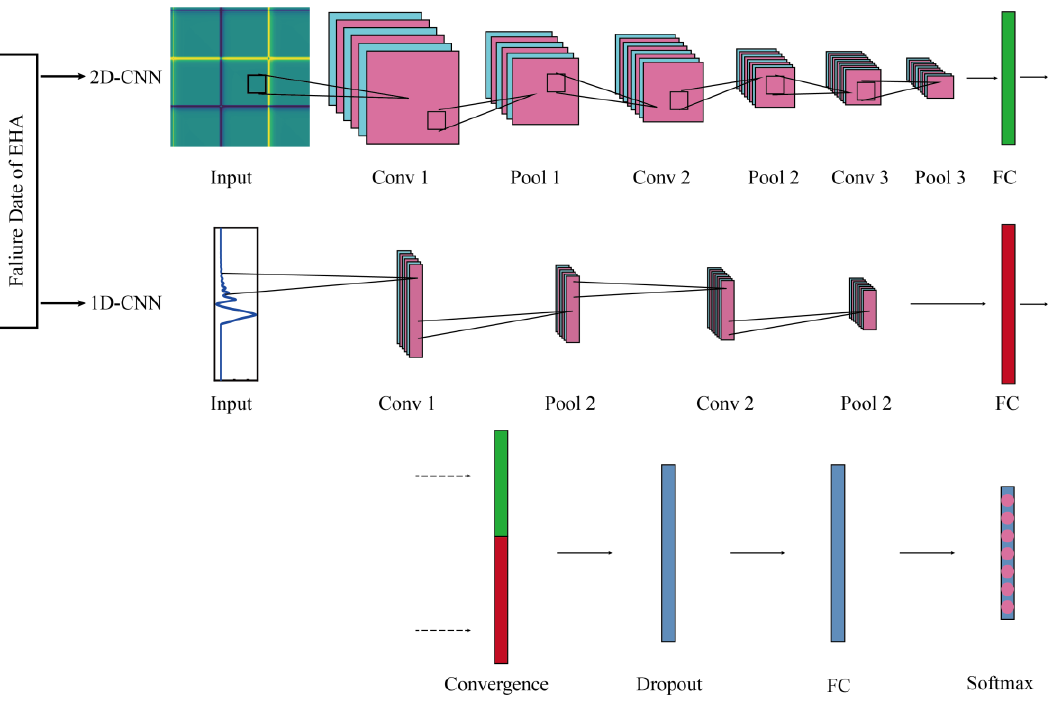
Figure 5. Structure of the proposed FCNN model.